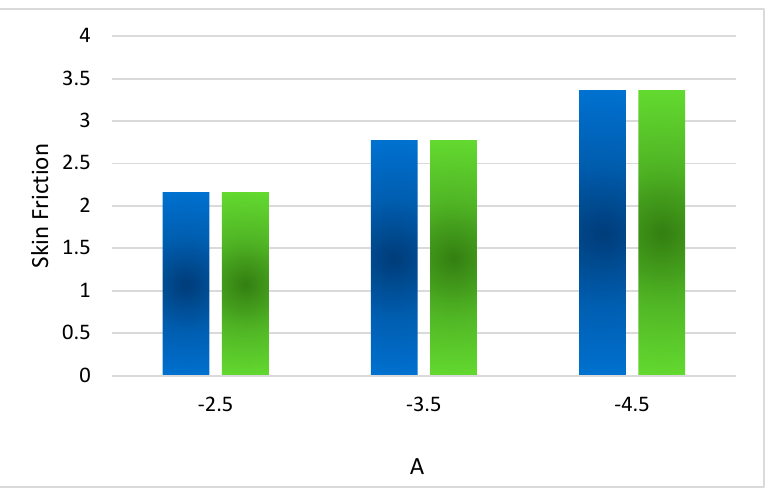
Figure 17. Revealing the consequences of A with the related skin friction coefficient.